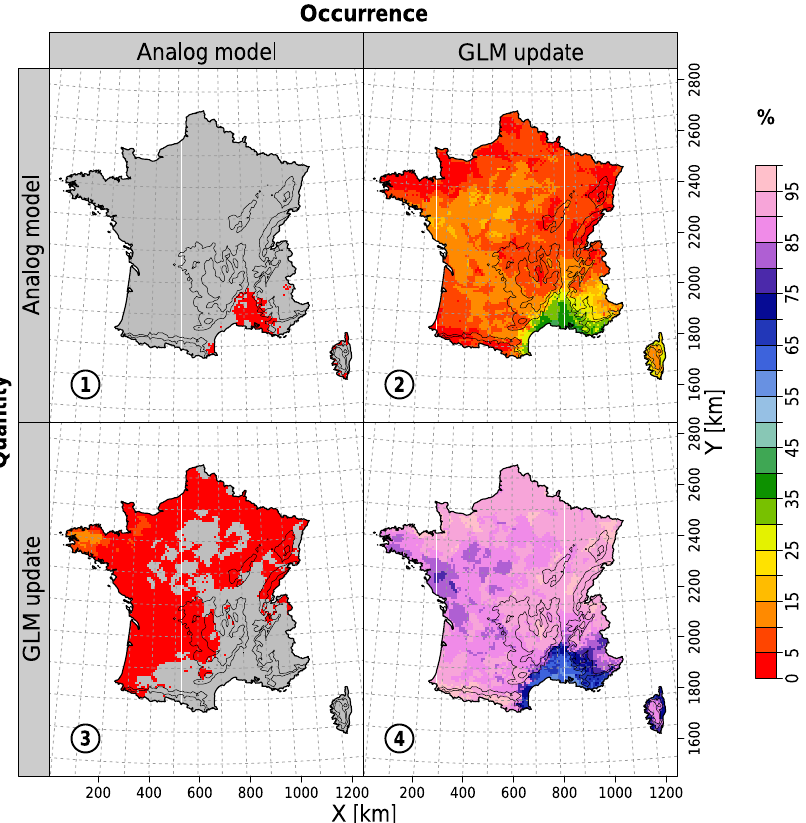
Figure 5. Percentage of days where (1) no updates are applied, (2) only the precipitation occurrence is updated, (3) only the precipitation amount is updated, and (4) the occurrence and the precipitation amount are updated. Grids with gray colors correspond to grid cells where the corresponding case has been met less than 35 times over the 20-year evaluation